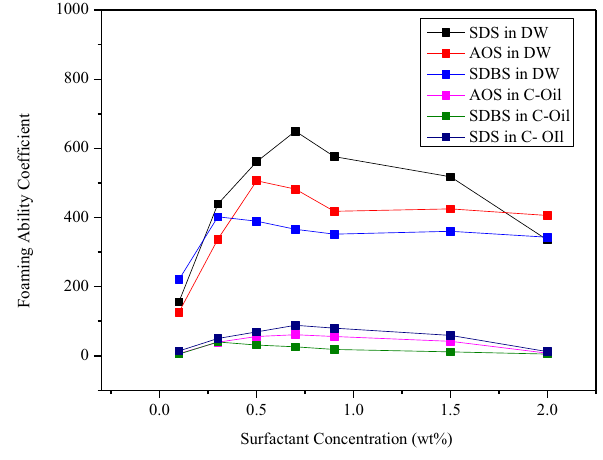
Fig. 2 Effect of surfactant type and concentration on foaming ability coefficient (in the absence and presence of crude